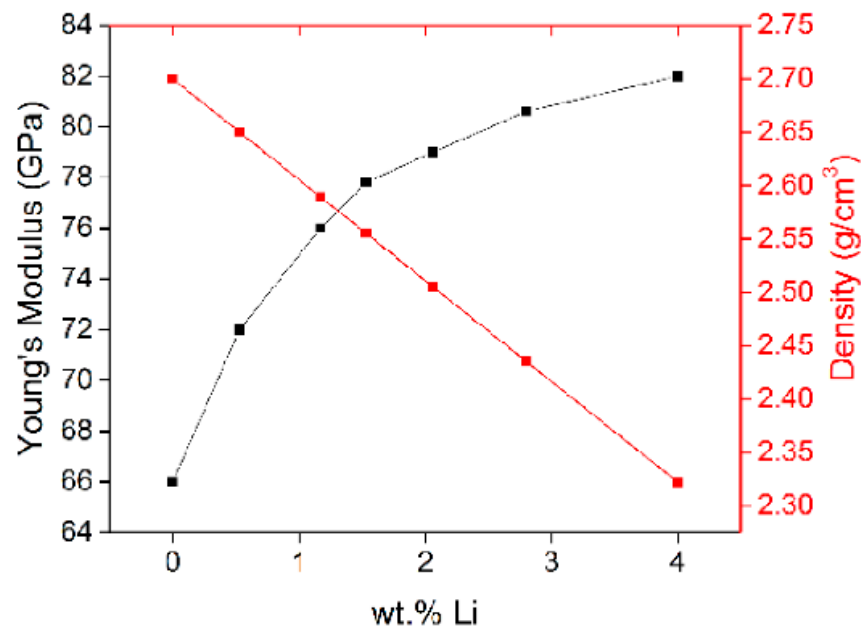
Figure 23. Lithium content versus density and Young’s modulus in Al–Li alloys [60].